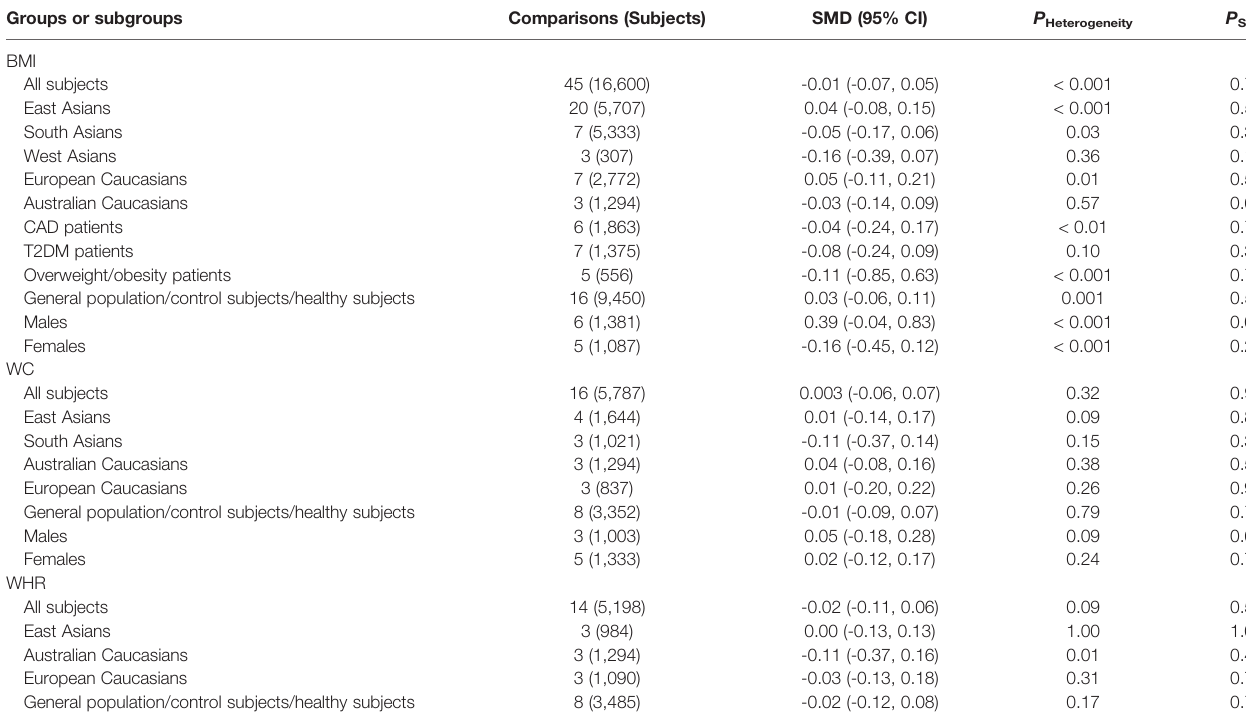
TABLE 3 | Meta-analysis between the rs3856806 polymorphism in PPARG and obesity indexes. Groups or